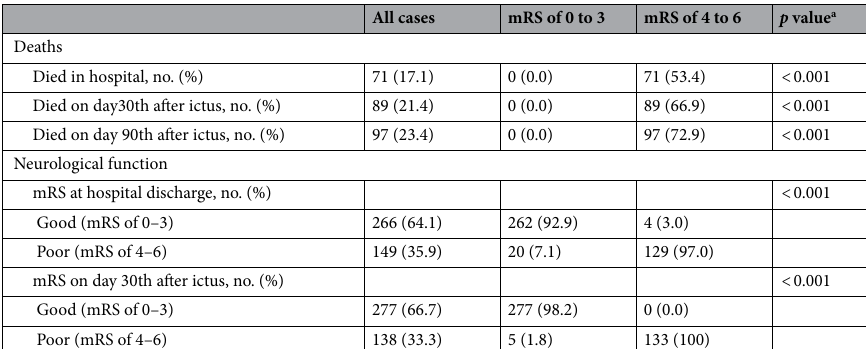
Table 1. Baseline characteristics, treatments, complications, and outcomes of patients with aneurysmal subarachnoid haemorrhage according to neurologic function on day 90th after ictus. See Table S2 to S9, as shown in Additional file 1, for additional information. COPD chronic obstructive pulmonary disease, DCI delayed cerebral ischaemia, EVD external ventricular drainage, GCS Glasgow coma scale, H&H Hunt and Hess, ICH intracerebral haemorrhage, IQR interquartile range, IVH intraventricular haemorrhage, mRS modified Rankin Scale, no. number, PAASH Prognosis on Admission of Aneurysmal Subarachnoid Haemorrhage, PCoA posterior communicating artery, SAH subarachnoid haemorrhage, SD standard deviation, VA vertebral artery, WFNS World Federation of Neurosurgical Societies. *Fisher’s exact test. **Mann–Whitney U test. a Comparison between mRS of 0–3 and mRS of 4–6 using Chi-squared test. b The descriptive SAH grading scales (i.e., the PAASH, WFNS, and H&H scales) were converted to the numerical SAH grading scales in ascending order (see Table S1, as shown in Additional file 1, for additional information). c Surgical haematoma evacuation was defined as any surgical procedure evacuating epidural, subdural, intraventricular, or intraparenchymal haematoma, such as decompressive craniotomy, open craniotomy, or minimally invasive